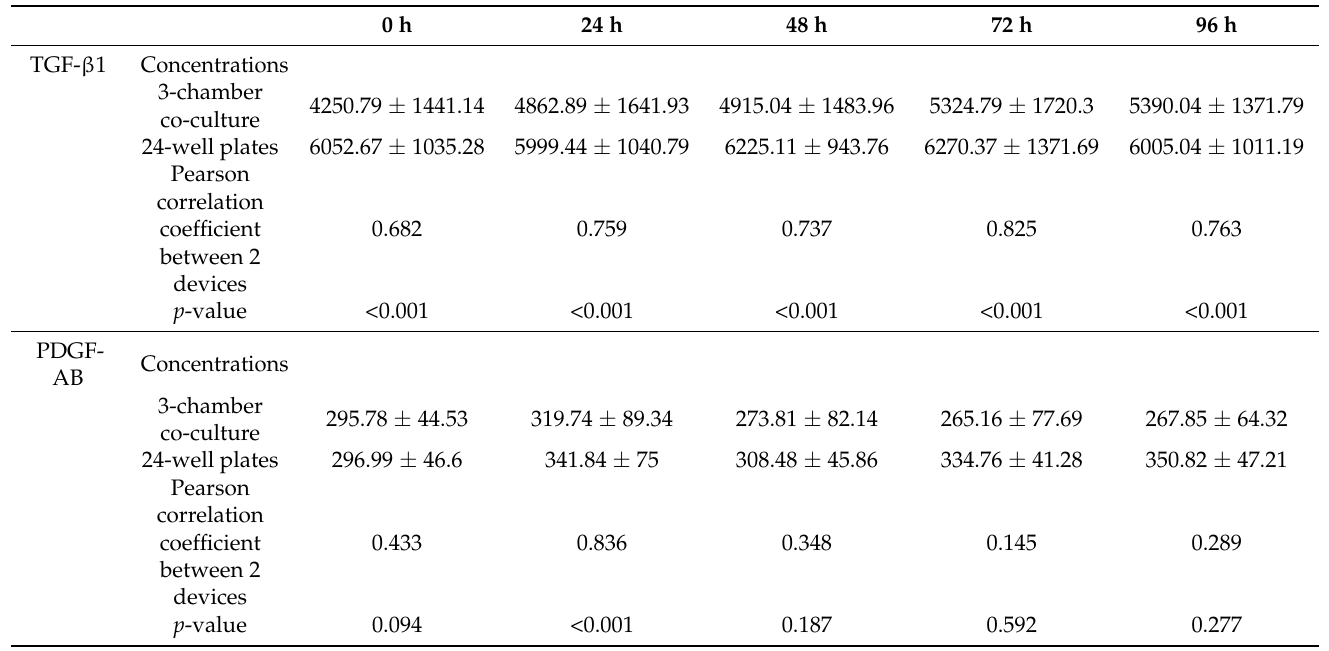
Table 2. The correlation between the concentration of TGF- β 1 and PDGF-AB in different time points and culture devices.